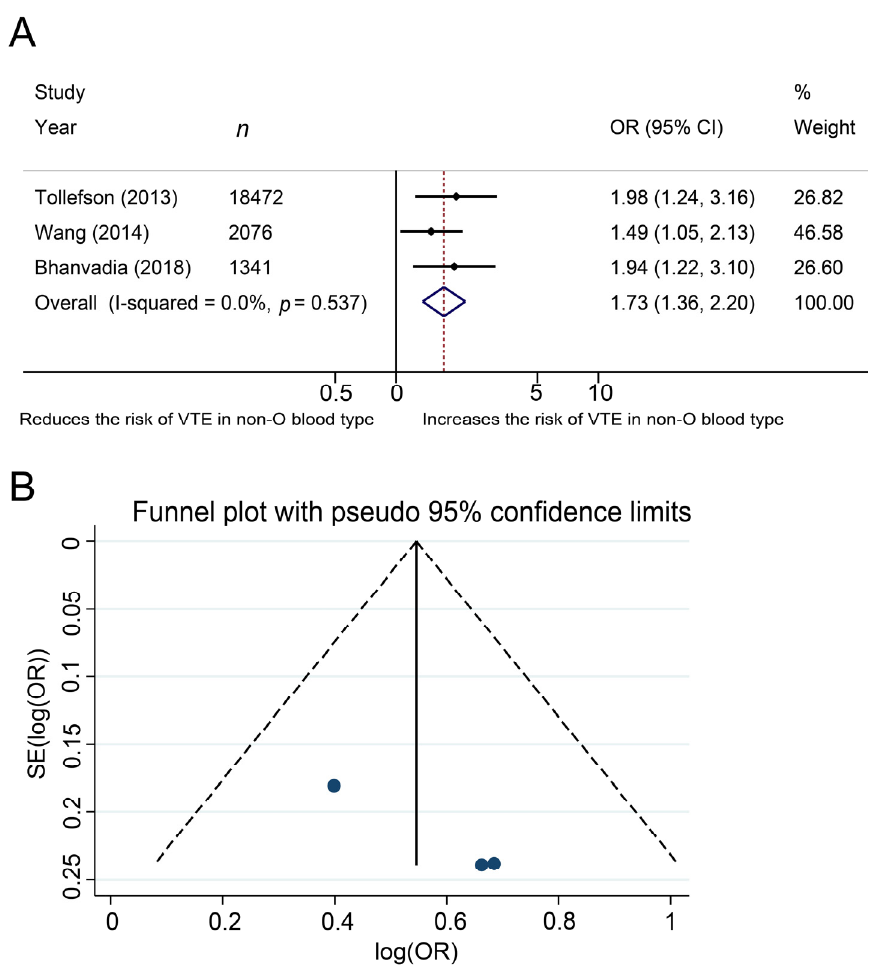
Figure 3. Forest ( A ) and funnel ( B ) plot showing the association of ABO blood type with development of venous thromboembolism among patients who underwent pelvic surgery for urological cancer.